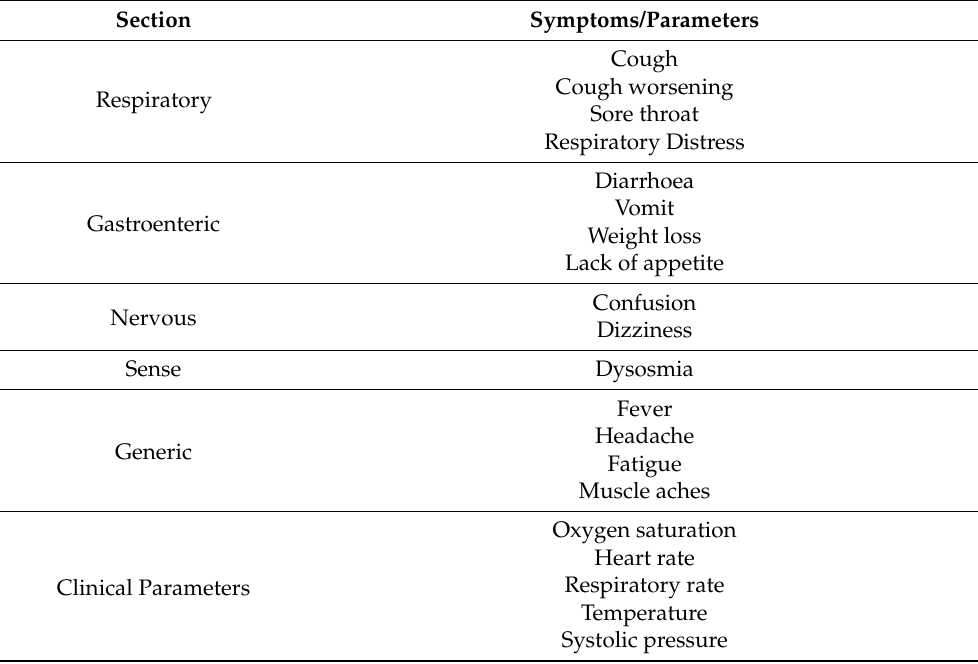
Table 1. Monitored symptoms and clinical parameters.